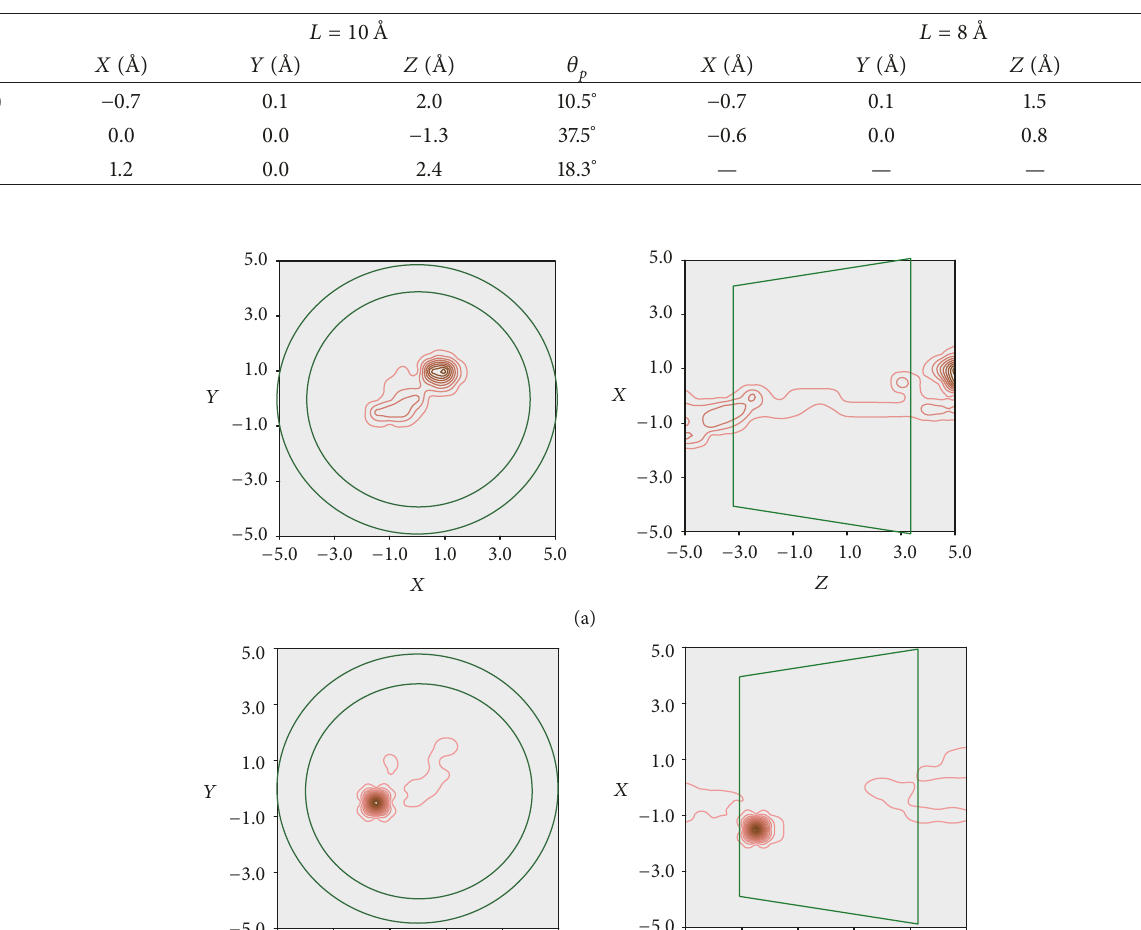
Table 4: The preferential configuration of the guest for linear molecules with 𝜎 1 = 2.5 ˚A, 𝜀 1 = 0.07 kcal/mol, 𝜎 2 = 3.7 ˚A, 𝜀 2 = 0.18 kcal/mol, the ratio of each pair p = 0.5, and different atomic distributions.